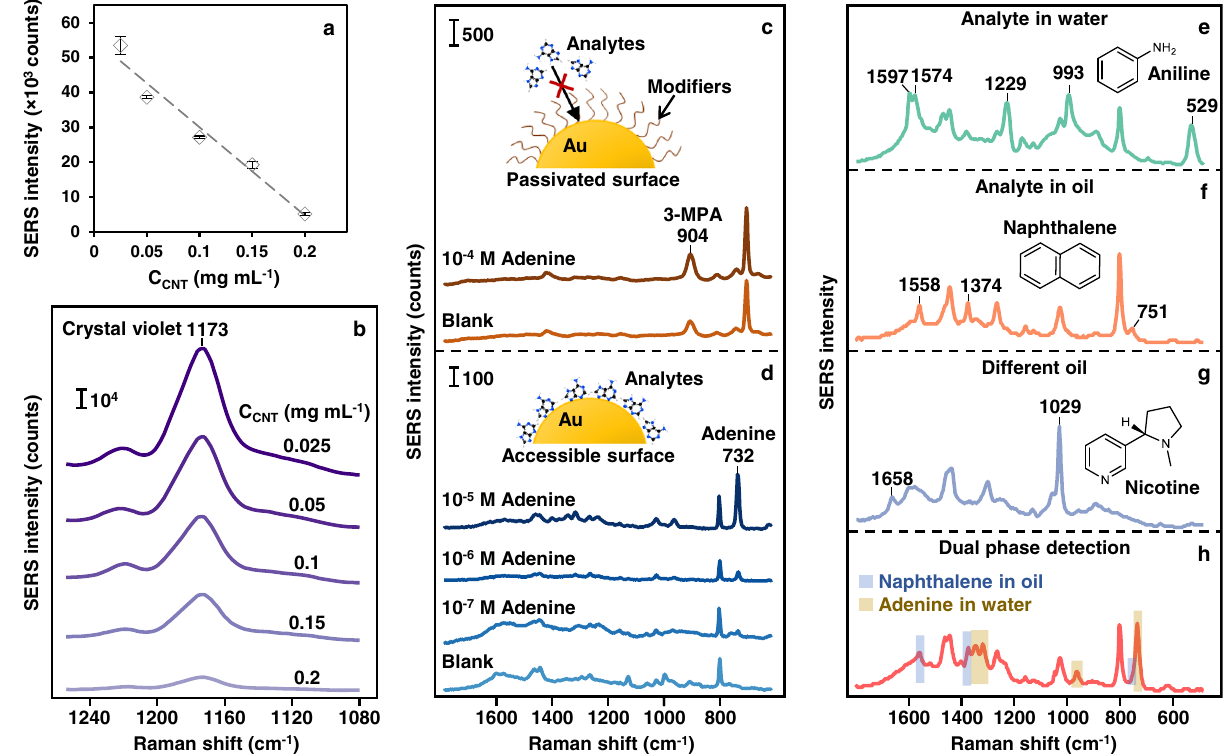
Fig.5|SERSsensingwithw/oCNT-AuNPPickeringemulsions.a Plotshowingthe SERSsignalintensityofcrystalvioletat10 -5 MobtainedusingCNT-AuNPsemulsions prepared at different CNT concentrations. The SERS intensity of crystal violet was calculated by measuring its characteristic peak at 1173cm − 1 . The standard devia- tions were calculated from N =3 independent samples. b The SERS spectra of crystalvioletcorrespondingtothedatapointsin a . c SERSspectraobtainedfrom3- MPA-cappedAuNPemulsionsbeforeandafterbeingtreatedwith10 − 4 Mofadenine. Nosignalsofadeninecanbeobservedsincethesurfaceof theAuNPsisblockedby the 3-MPA modi fi ers. d SERS spectra obtained from CNT-AuNP emulsions treated with various concentrations of adenine. The surface of the AuNPs is accessible